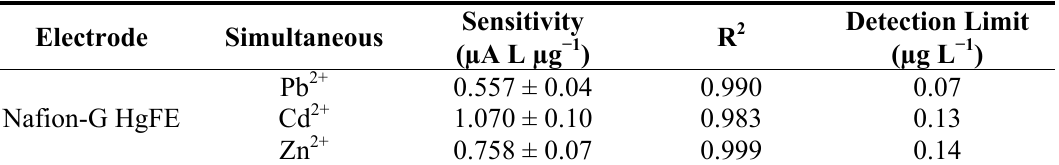
Table 2. Sensitivity values, correlation coefficients (R 2 ) and detection limits of Pb 2+ , Cd 2+ and Zn 2+ determined simultaneously on a Nafion-G mercury film electrode.